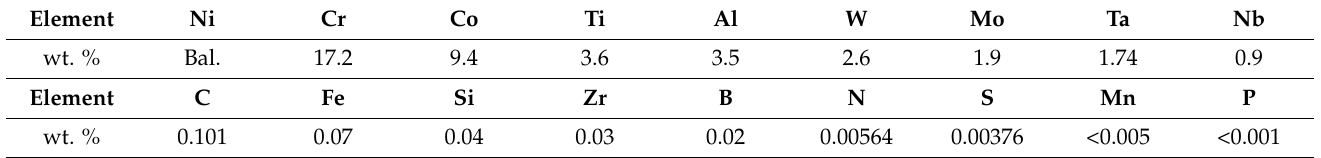
Table 2. Chemical composition of the IN738LC superalloy powder in the as-gas-atomized